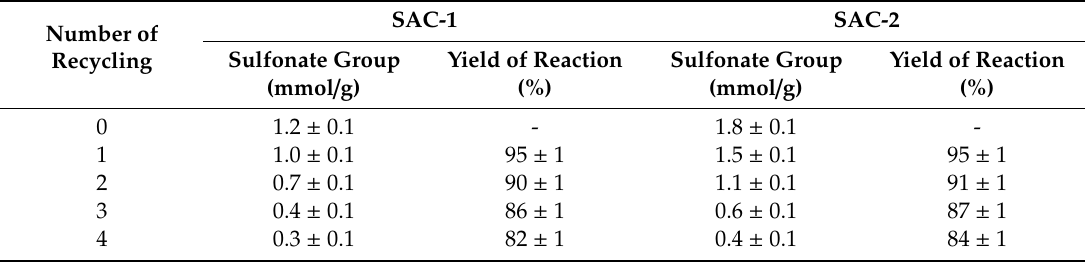
Table 6. E ff ects of number of reuse times of SAC-1 and SAC-2 on sulfonate group and yield of